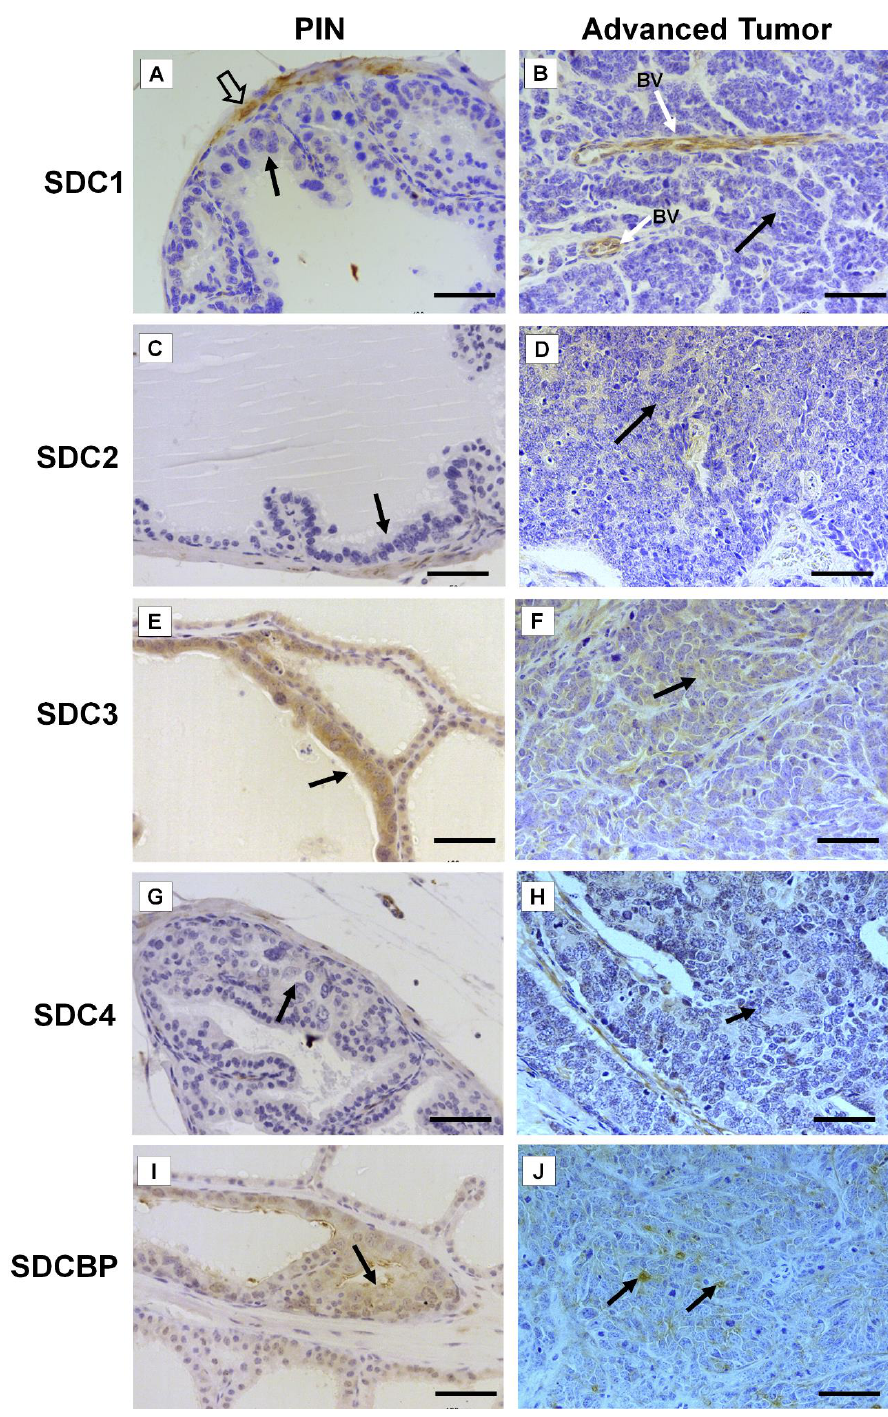
Figure 3. Representative images of the immunohistochemical staining for SDC1, -2, -3, and -4, and SDCBP in tumors found in the different prostatic lobes from the Pb-Cre4/Trp53f/f-;Rb1f/f genetically engineered mouse model. ( A , B ) SDC1; ( C , D ) SDC2; ( E , F ) SDC3; ( G , H ) SDC4; ( I , J ) SDCBP. Prostatic intraepithelial neoplasia (PIN) and advanced tumors (AdTumor). In the PIN areas and advanced tumors, positive immunostaining was observed for SDC3 ( E ) and SDCBP ( I ) (solid arrows). Blood vessels (BV); smooth muscle cells (open arrow). Scale bars: 100 μm.